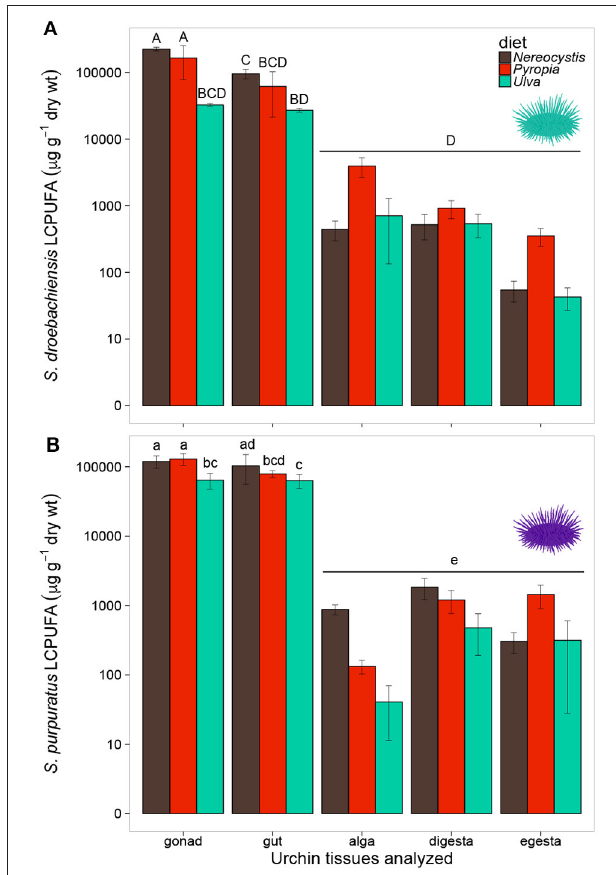
FIGURE 5 | Concentrations ( µ g g − 1 dry tissue weight) of long chain polyunsaturated fatty acids (LCPUFA—sum of ARA, EPA, and DHA) of tissues (gonad, gut, alga, digesta, egesta) collected from feeding assays with (A) S. droebachiensis and (B) S. purpuratus . Bars with the same letter are not significantly different (2-way ANOVA, Tukey HSD, p < 0.05). Concentrations are plotted on a logarithmic scale and error bars represent ± standard deviation, SD .